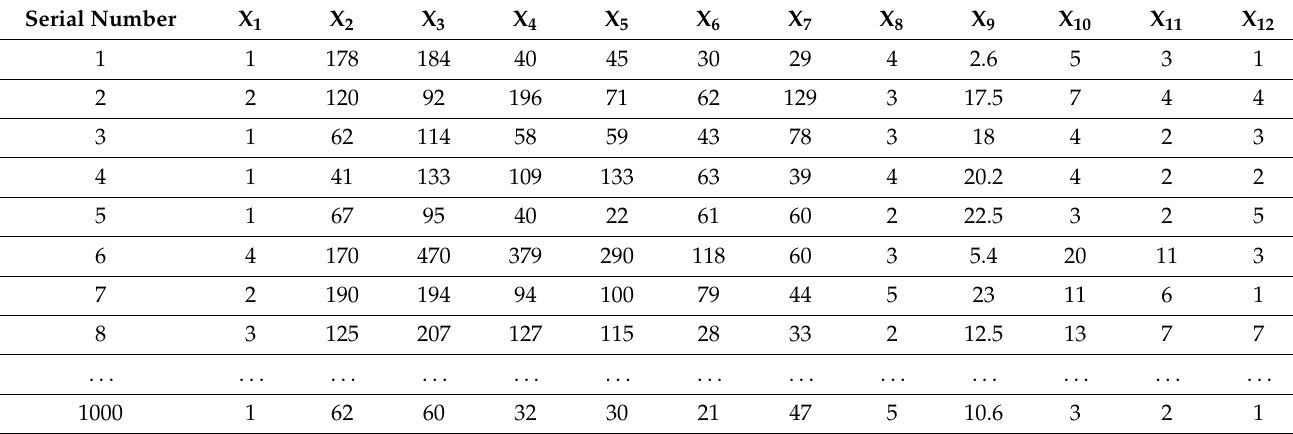
Table 4. Container ship operation information